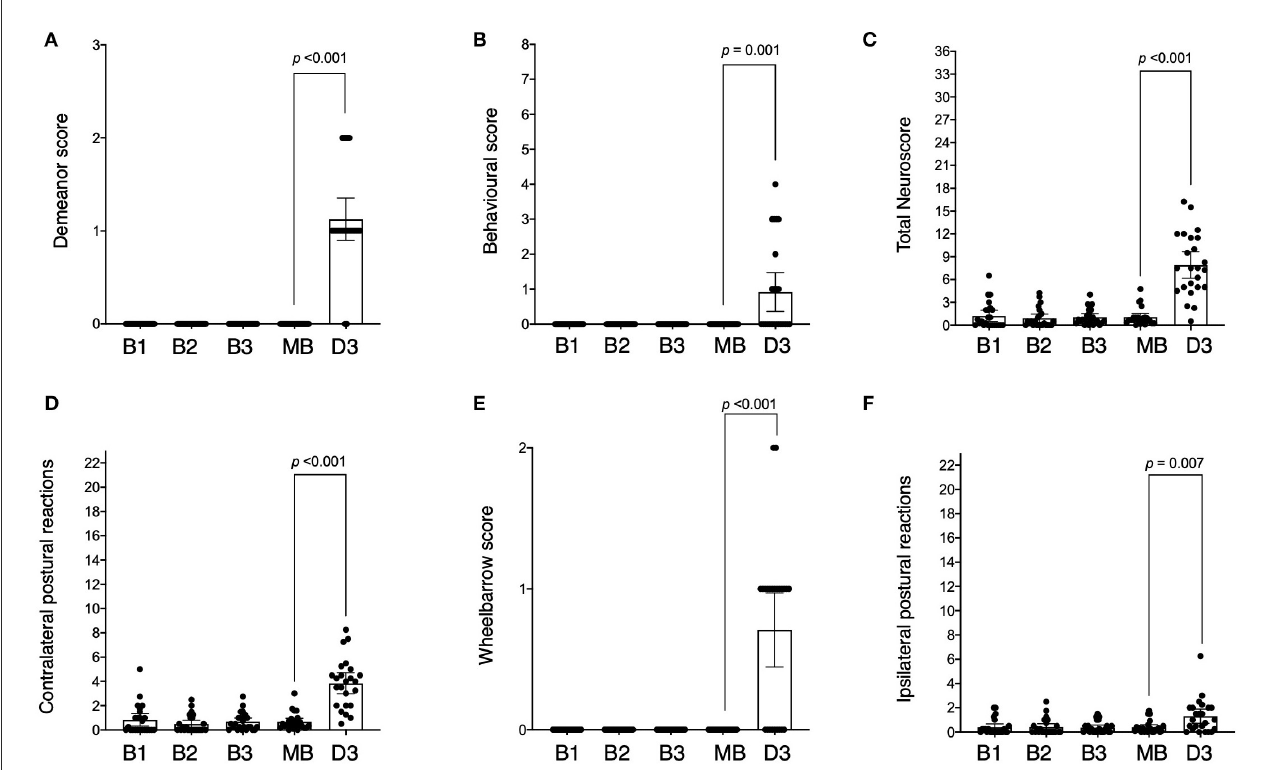
FIGURE3 Neurological scores across baseline and post-stroke testing sessions. Sessions are indicated as baseline 1 (B1), baseline 2 (B2), baseline 3 (B3), mean of all the baselines (MB), and day 3 post-stroke (D3). Scores across testing sessions are shown for demeanour [ (A) score range 0–3], behaviour [ (B) score range 0–8], ipsilateral postural reactions [ (C) score range 0–23], contralateral postural reactions [ (D) score range 0–23], wheelbarrowing [ (E) score range 0–2] and total neuroscore [ (F) score range 0–36]. The difference ( p -value) between mean baseline and day 3 post-stroke is indicated as